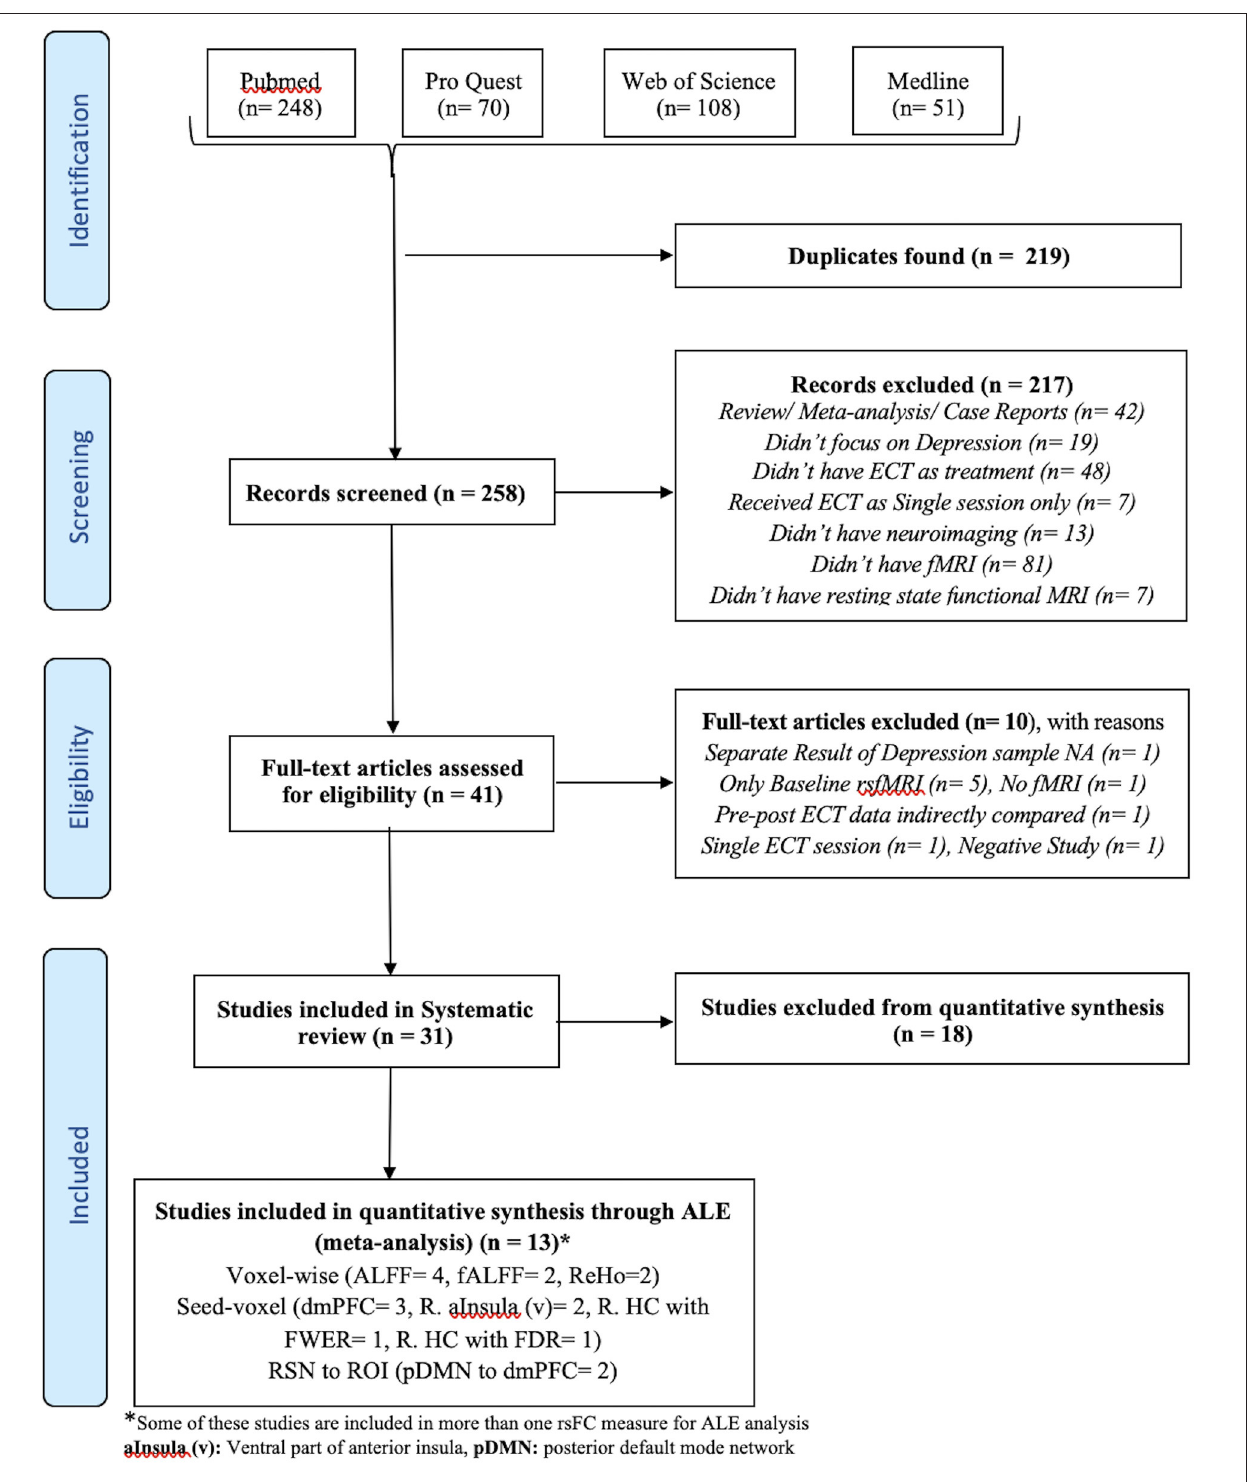
FIGURE 1 | Flow diagram of literature search and study selection. *Some of these studies are included in more than one rsFC measure for ALE analysis. aInsula (v), Ventral part of anterior insula; pDMN, posterior default mode network.